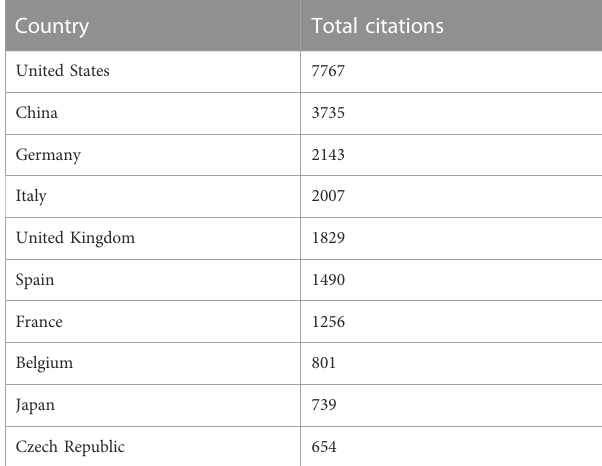
TABLE 2 Top 10 most cited countries.